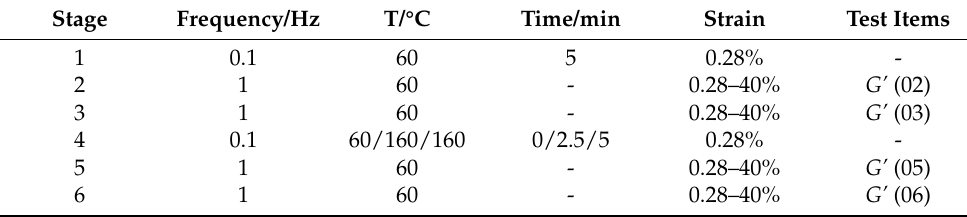
Table 3. Stages of the RPA method to measure the degree of the silanization